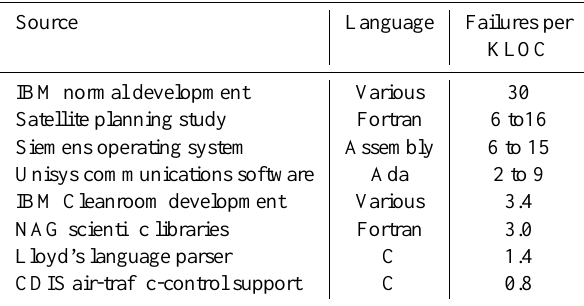
Table 1. Post-delivery problem rates as reported by Pfleeger